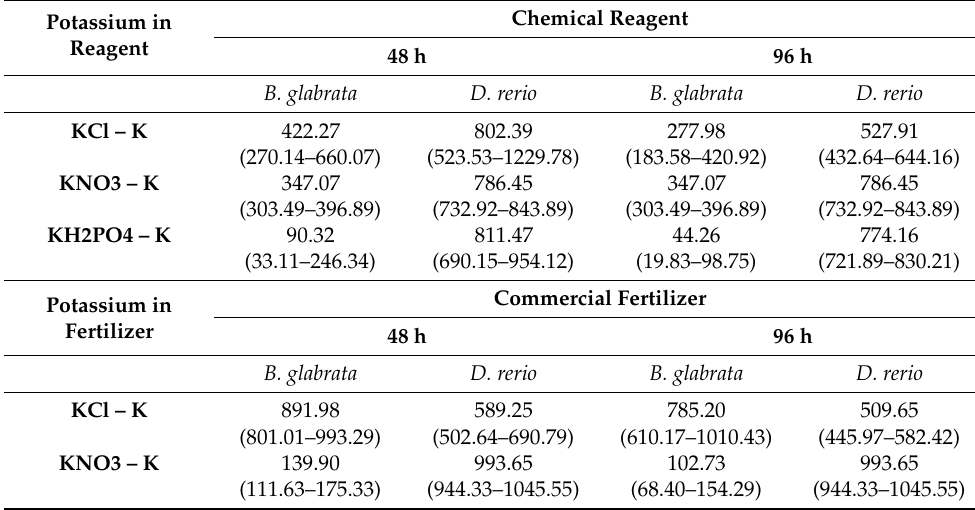
Table 3. Comparison between the lethal concentrations (LC50s) obtained in different assays with potassium present for the reagent and the commercial fertilizer for the B. glabrata snail and the D. rerio fish (units mg · L − 1 ). Values in brackets represent the 95% confidence intervals.